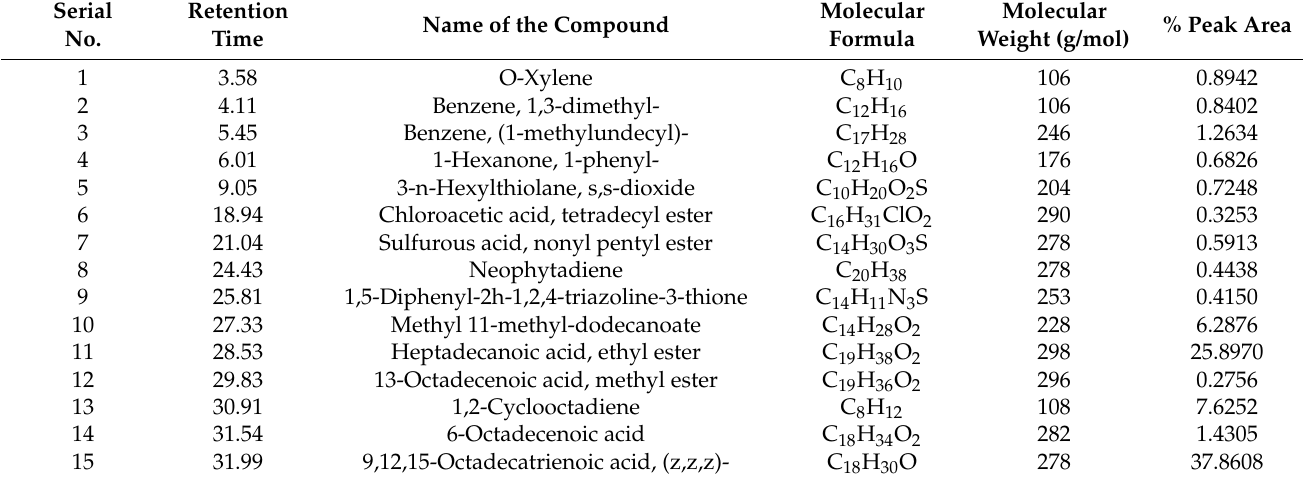
Table 1. Gas Chromatography-Mass spectroscopic data of c ompounds in G. tetrandra ethanol leaves